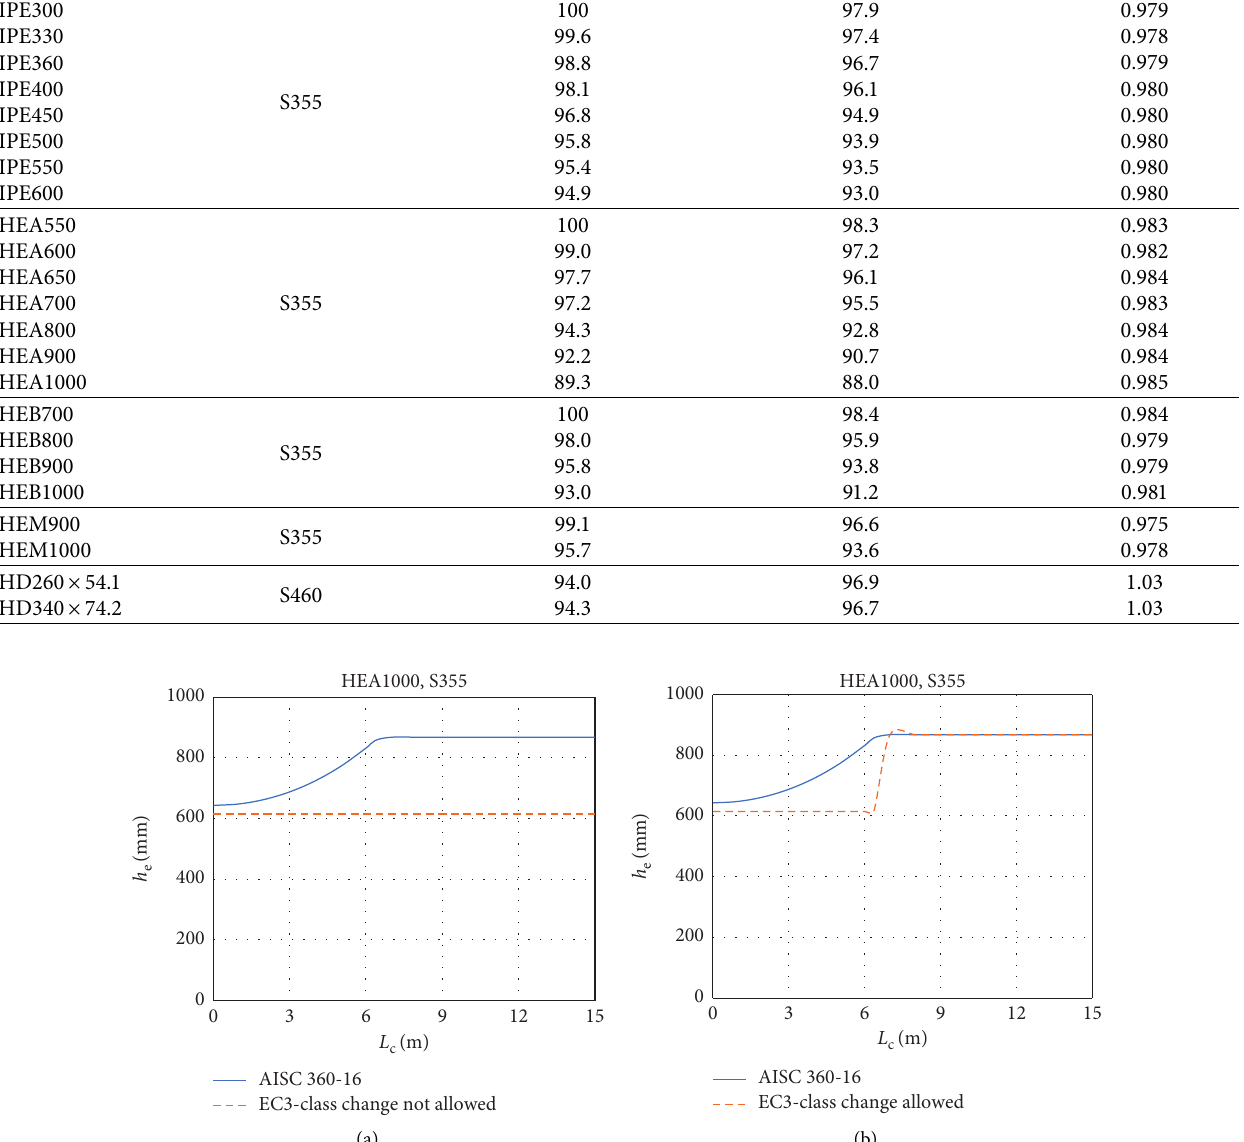
Table 3: Comparison of the effective cross-sectional areas of compression members with slender-element sections computed according to AISC 360-16 ( A e,AISC 360-16 ) and those with Class 4 sections computed according to EC3 ( A e,EC3 ). Section